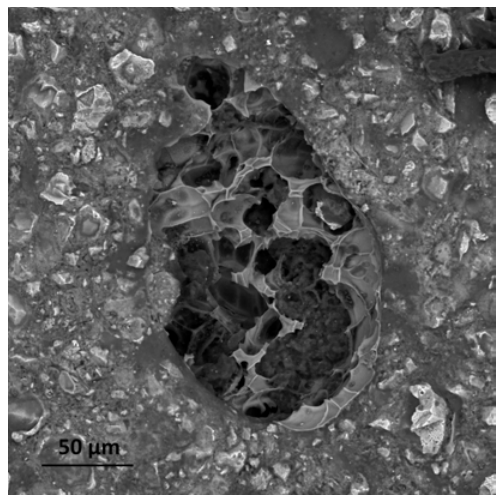
Figure 4. BSE micrograph showing microstructure of cement paste with perlite